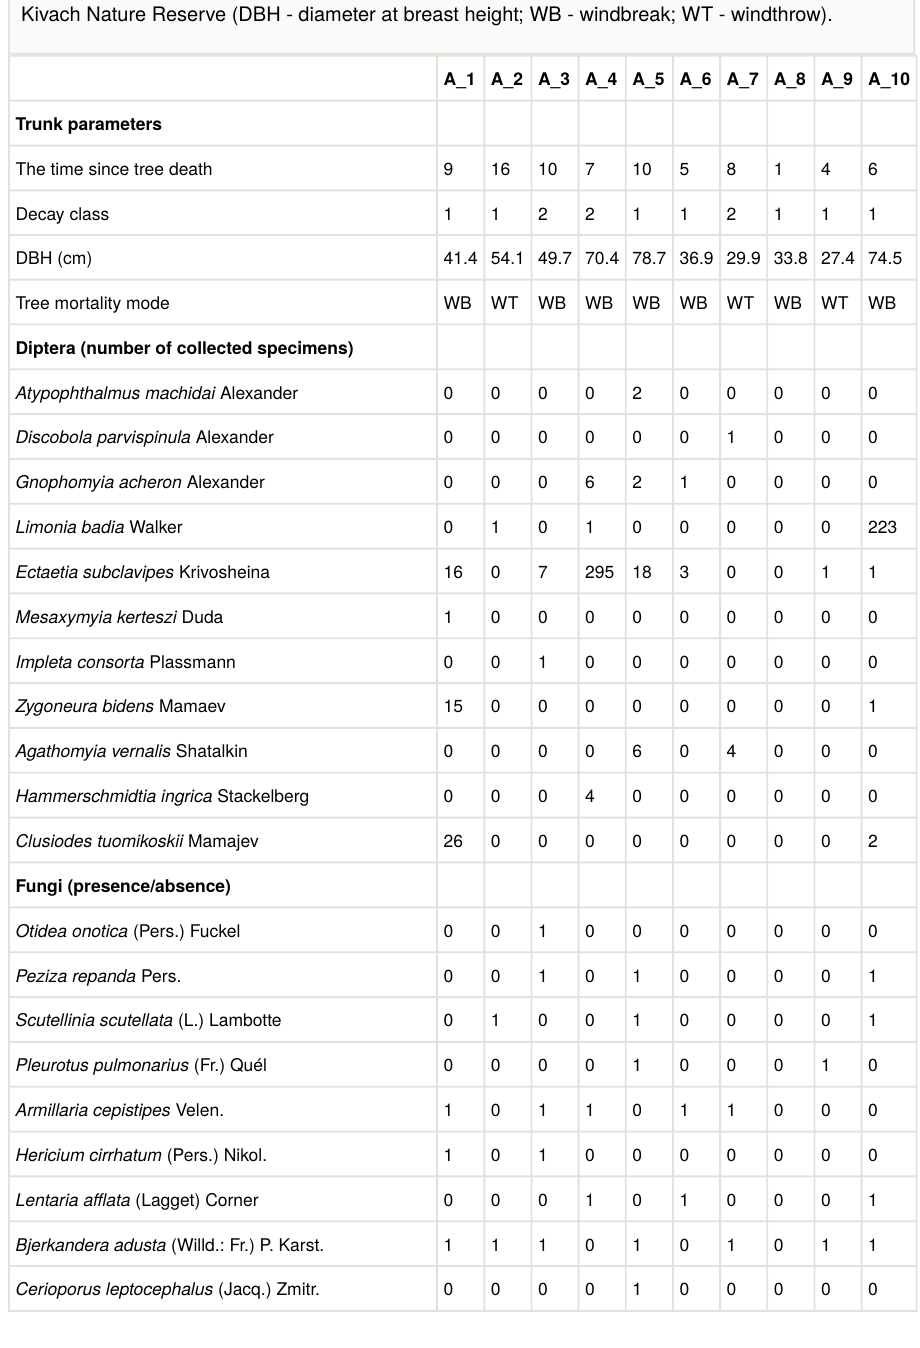
Occurrence of remarkable Diptera species and wood-decaying macromycetes on fallen aspens in Kivach Nature Reserve (DBH - diameter at breast height; WB - windbreak; WT